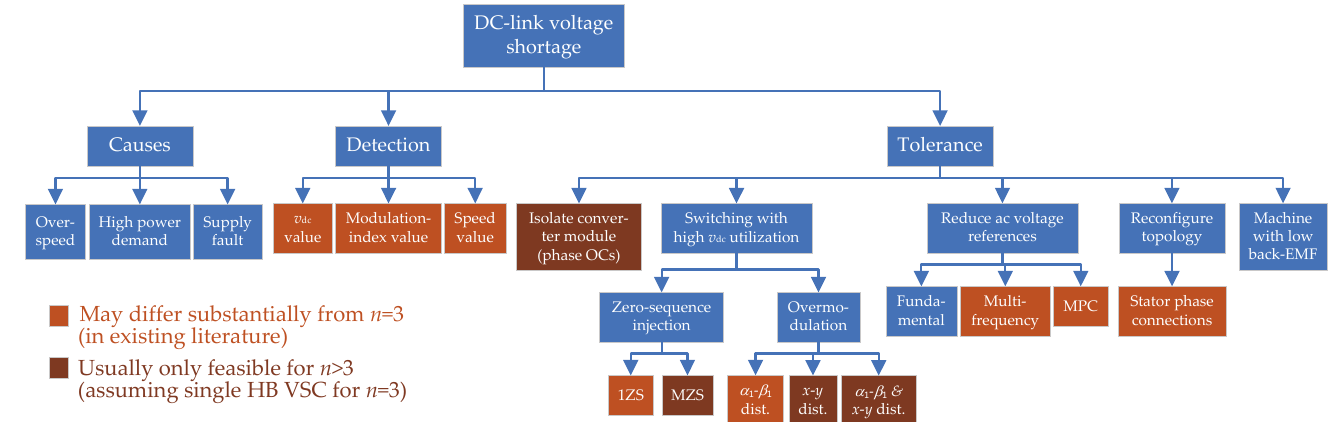
Figure 24. Causes, detection methods and tolerance approaches for dc-link voltage shortage in multiphase